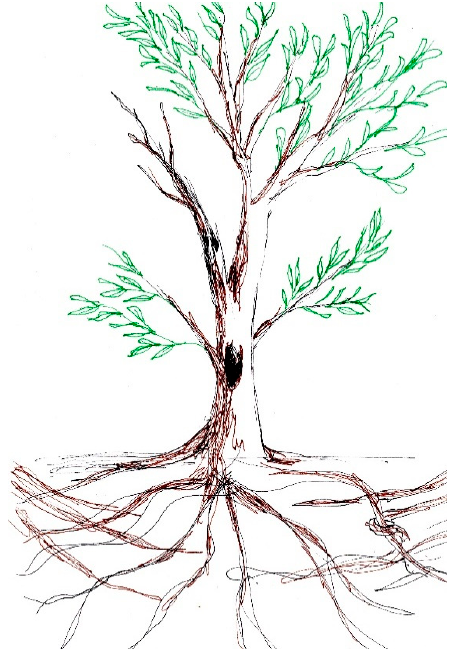
Figure 3. Tom’s drawing.